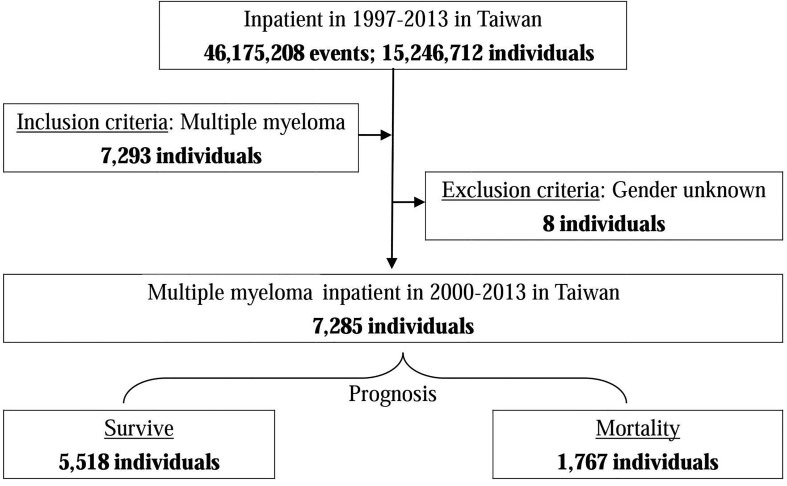
Flowchart of the study sample selection from the National Health Insurance Research Database in Taiwan.Multiple myeloma: ICD-9-CM 203.0; Inclusion criteria: Multiple myeloma; Exclusion criteria: Gender unknown.